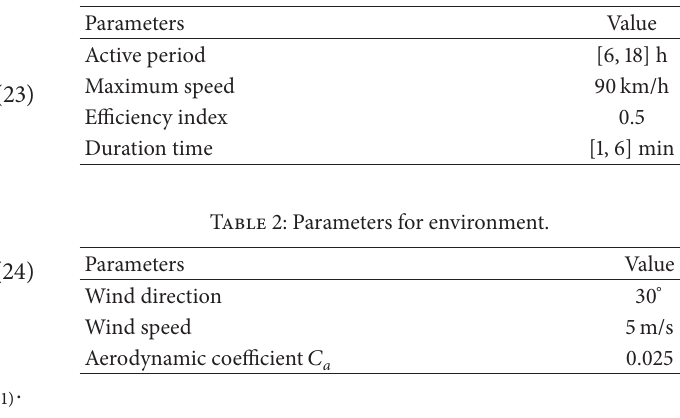
Table 1: Parameters for high-altitude airship.